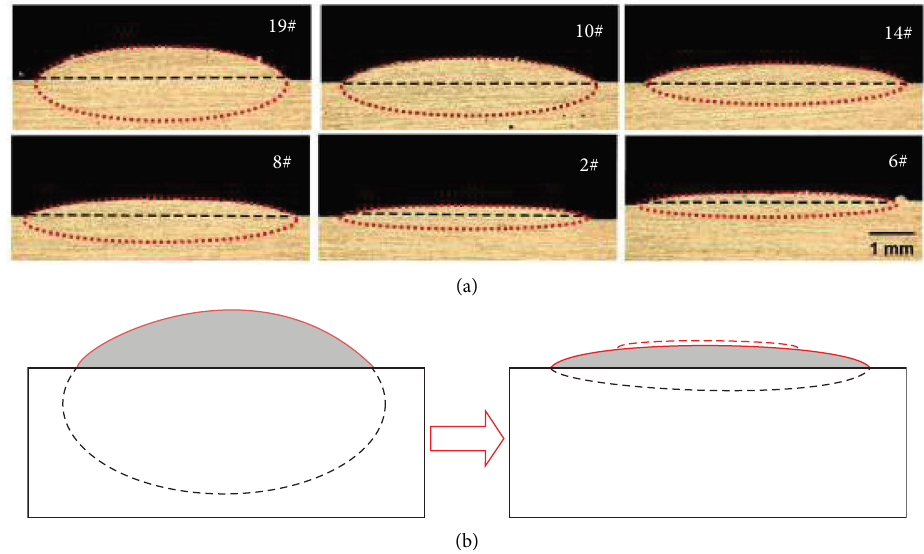
Figure 9: Ellipse ftting of the track cross-section. (a) Ellipses of diferent tracks (the upper right number of each photograph is consistent with Table 2); (b) the deformation tendency of the ftting